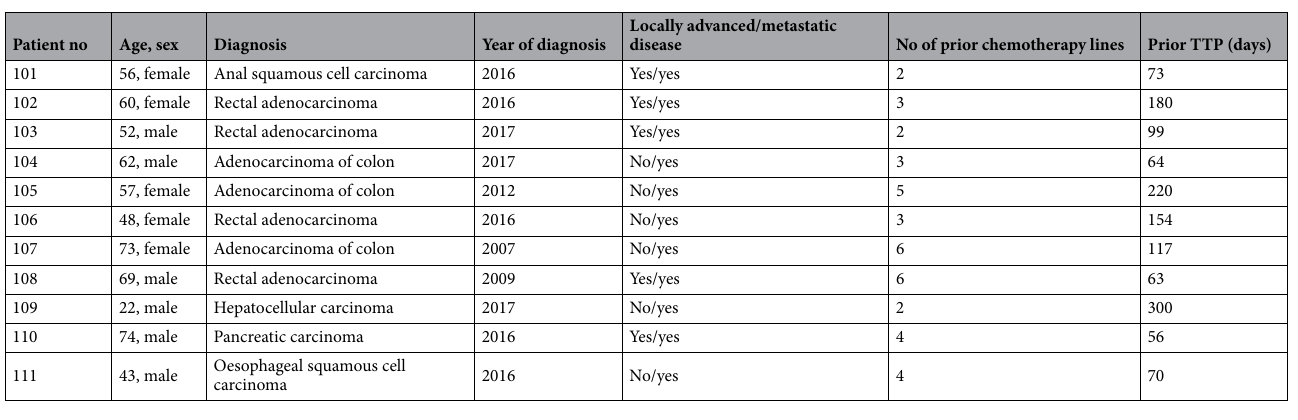
Table 1. Characteristics of the patients included. TTP time to tumour progression on the chemotherapy regimen preceding enrolment in this